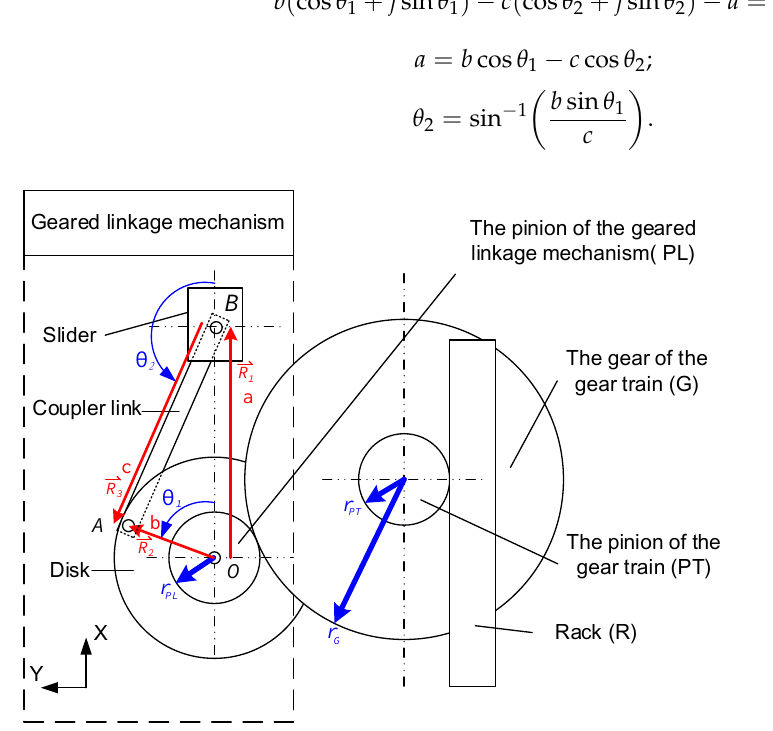
Figure 3. Schematic diagram of the frequency up-conversion mechanism. The schematic diagram of the frequency up-conversion mechanism is shown in Figure 3. This mechanism includes a rack, a gear train, and a geared-linkage mechanism. The rack was excited by wave motion and drove the gear train for rotational motion. We as- sumed a single sinusoidal wave motion. The displacement and velocity of the rack can be